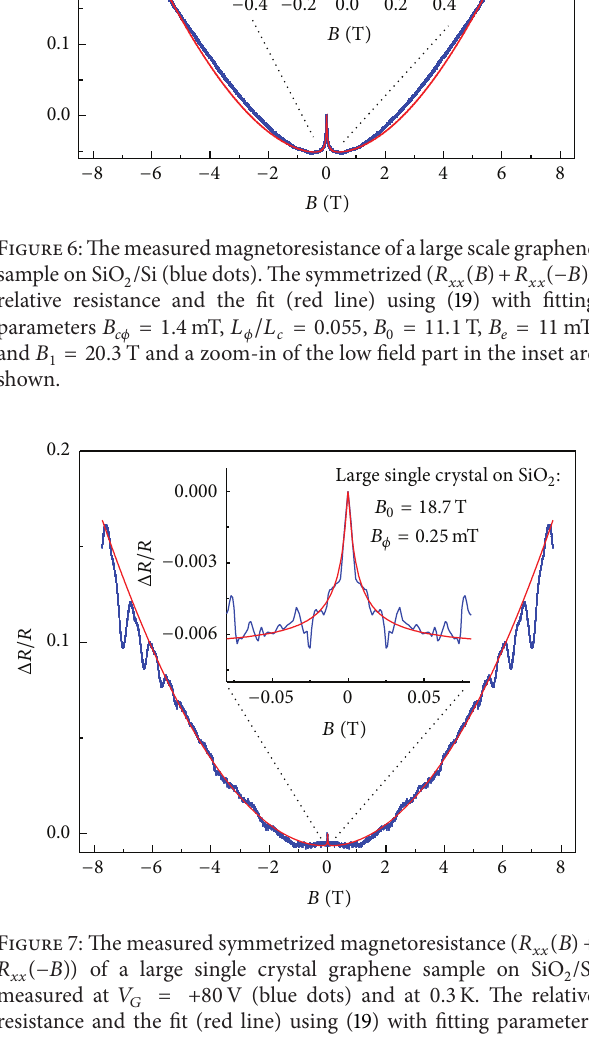
2 /Si = 3.5 mT are 𝑒